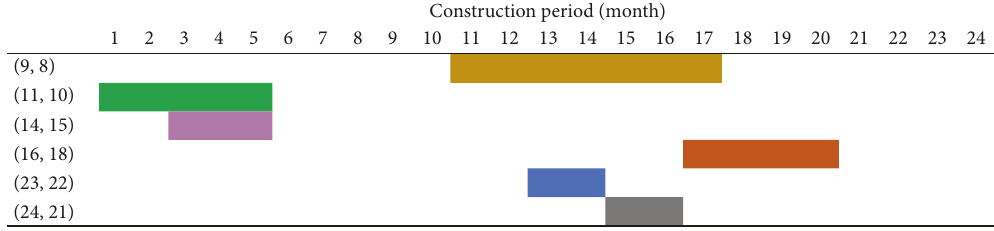
Table 6: Selection and scheduling results for Example 2 . Stating time Ending time